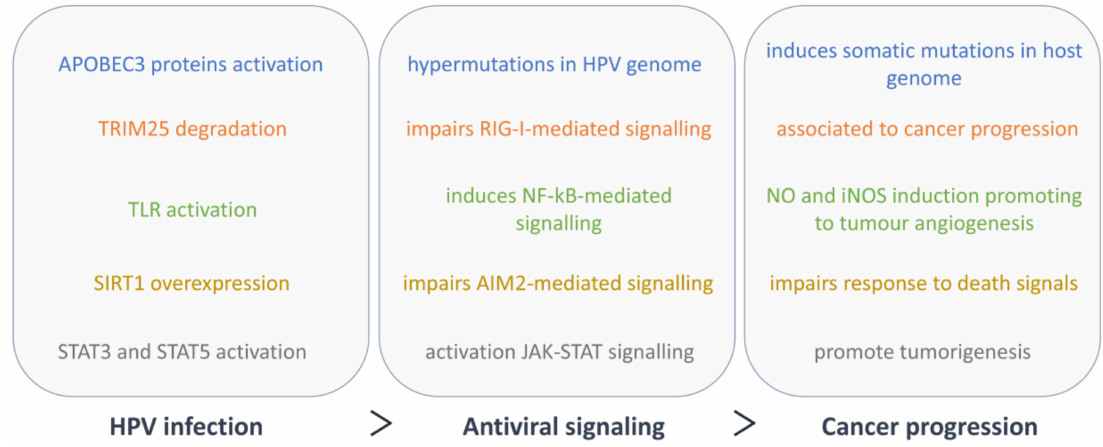
Figure 4. HPV evasion of the antiviral signalling and corresponding impact on